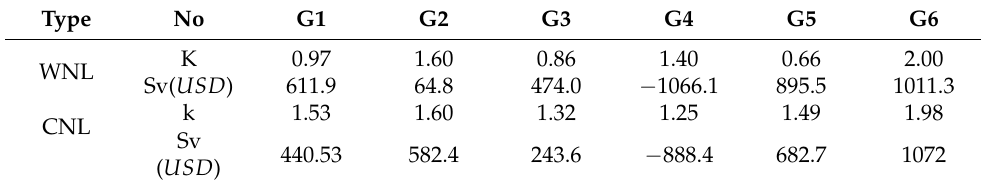
Figure 11. The characteristic function value of v(Sc) for completely CB at hour 8. Table 2. Optimal BS and SV of each power provider for completely CB at hour